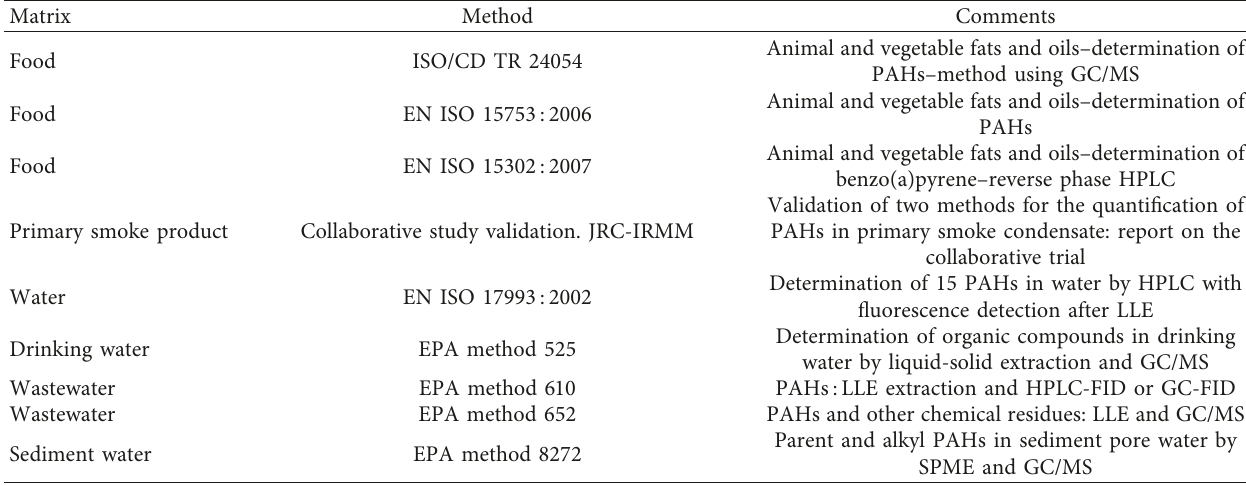
Table 6: Standardized methods for PAHs determination in various matrices